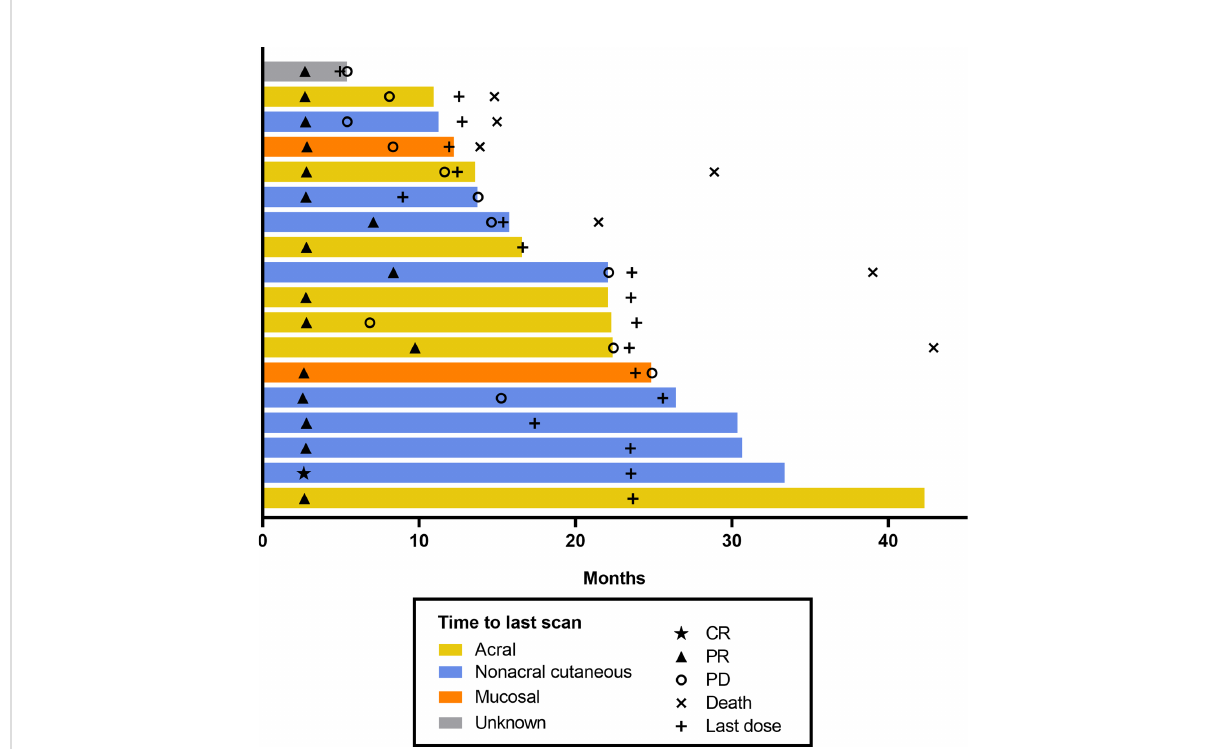
FIGURE 2 Swimmer plot of time to response per RECIST v1.1 by BICR (patients with response in the FAS population). BICR, blinded independent central review; CR, complete response; FAS, full analysis set; PD, progressive disease; PR, partial response; RECIST v1.1, Response Evaluation Criteria in Solid Tumours, version 1.1.